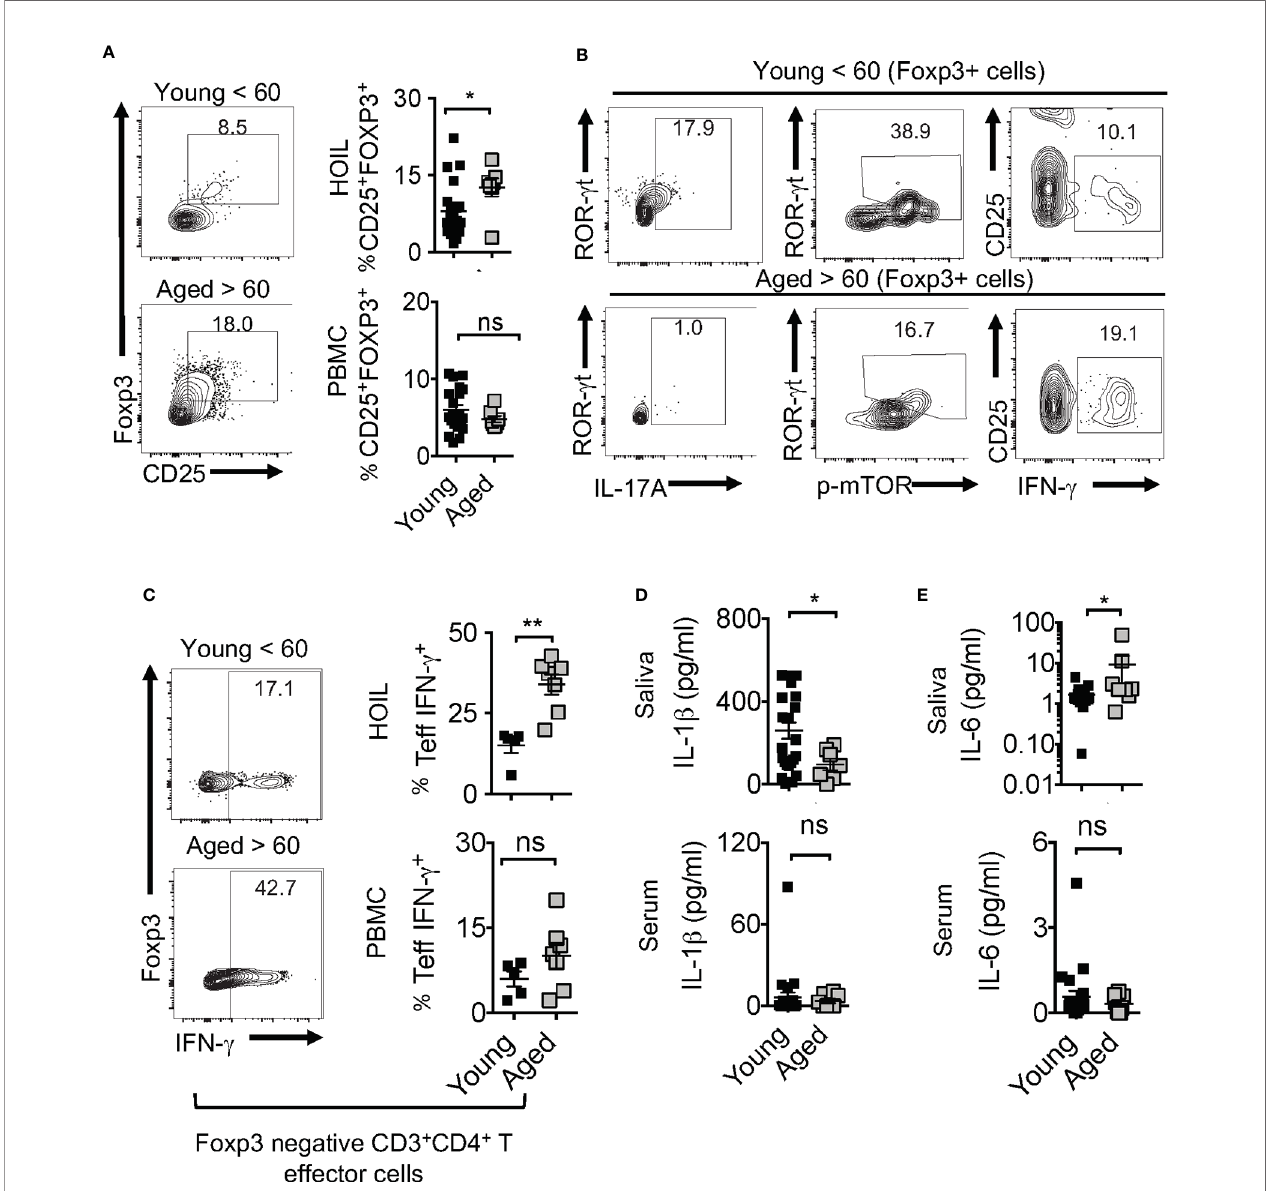
FIGURE 10 | Aged individuals have decreased T reg 17 cells and increased T regDys , correlating with CD4 T cell hyperactivation in oral mucosa. 32 human participants were recruited to the study (Male n=13, Female n=19; Aged < 60 n = 25; Aged > 60 n=7). Gingival biopsies and peripheral blood mononuclear cells (PBMC) were collected. Human oral intra-epithelial and lamina propria leukocytes (HOIL) and PBMC were obtained by processing gingival biopsy tissues and blood, respectively. Flow cytometric plots showing HOIL Foxp3 and CD25 expression; Geometric Mean of CD25; Young=1387 Aged= 744 (A) and statistical analysis of T reg proportions in CD3 + CD4 + of HOIL (above) and PBMC (below) (n=32). (B) Flow cytometric plots showing ROR- g t and IL-17A (left), ROR- g t, p-mTOR(middle), CD25, and IFN- g (right) in HOIL Foxp3+ cells. (C) Flow cytometric analyses of non-T reg CD4 + HOIL (above) and PBMC (below) cells showing IFN- g expression ex vivo (n=12) (CD3 + CD4 + Foxp3 neg gated). ELISA quanti fi cation of IL-6 (D) , and IL-1 b (E) , in saliva (above) and serum (below) collected from the participants. Mean values ± SEM are plotted. (*P < 0.05; Mann Whitney test). **P < 0.005. NS, non-signi fi